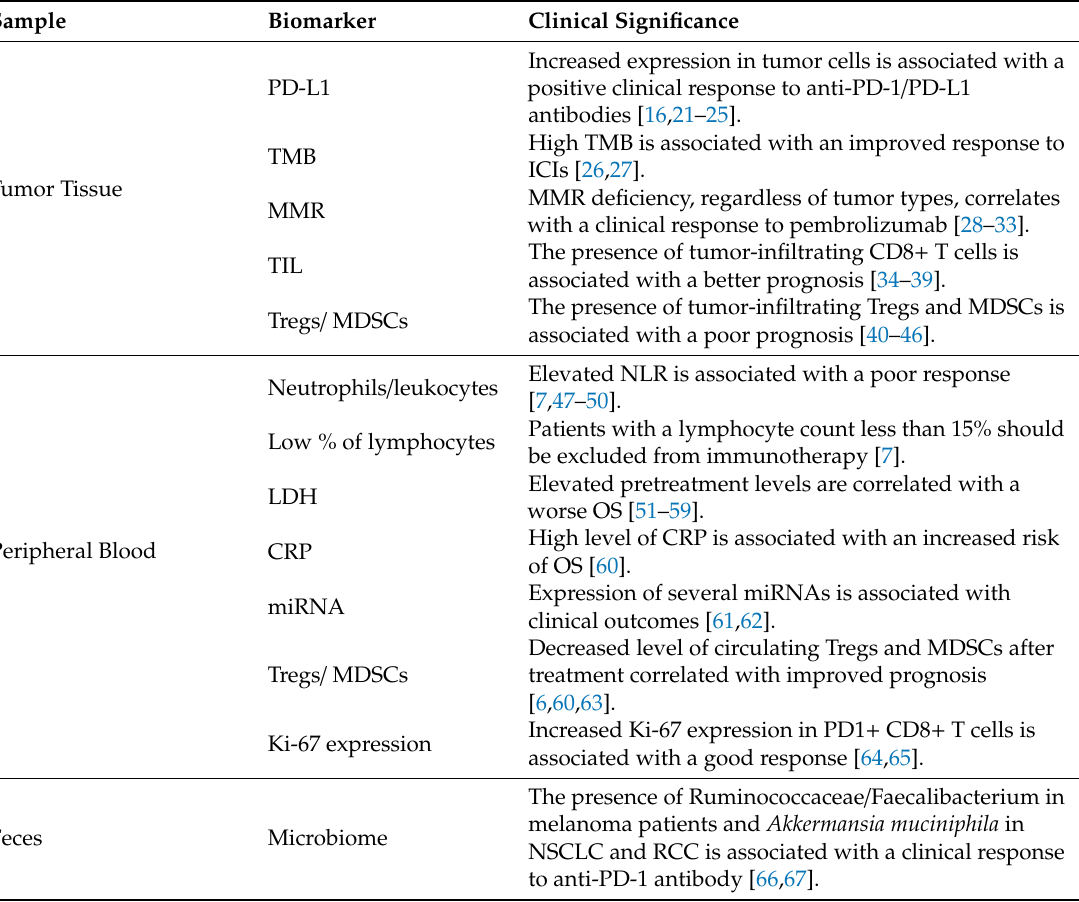
Table 1. Biomarkers for cancer